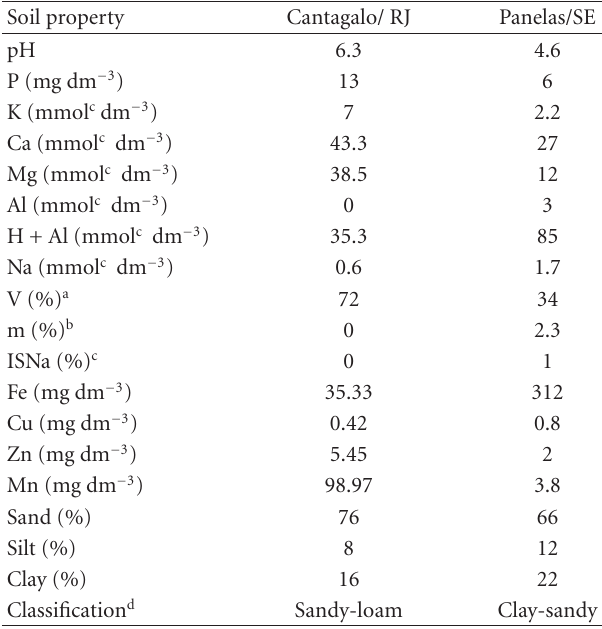
Table 2: Physical and chemical characteristics of Cantagalo and Panelas